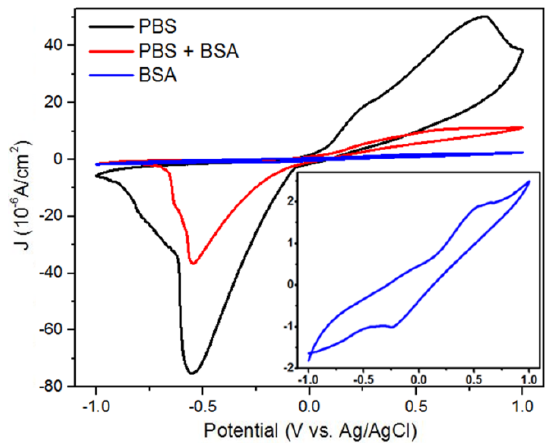
Figure 6. The experiment results of the CV measurement of the Ag thin film using the PBS, PBS+BSA, and BSA media.